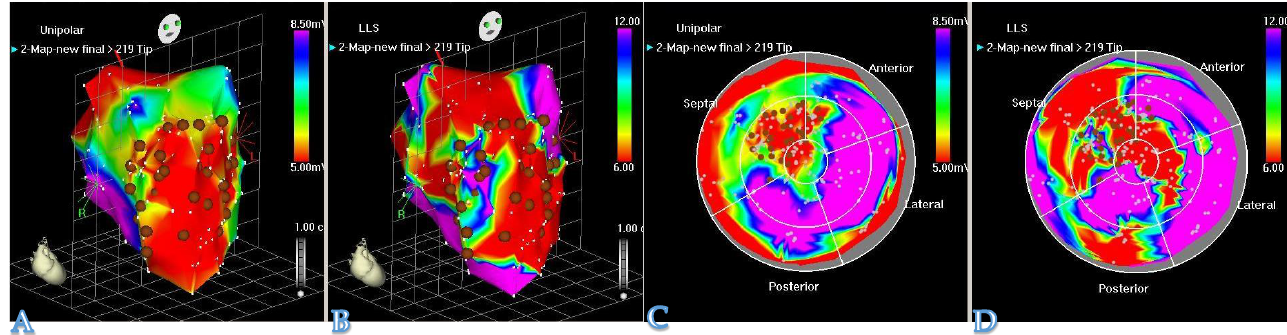
Figure 3. The NOGA ® system allows visualization of the LV contraction in 3D. NOGA is able to map the heart in a full 360 ◦ rotation. ( A , C ): unipolar voltage maps (mV) and ( B,D ): regional wall motion maps by local linear shortening (LLS%) can help the electromechanical assessment of the myocardium. NOGA shows viability on the left column; dense scarring is visible at the apex and the antero-septal wall (red); scar area (<0.5 mV) = RED; viable tissue (>1.5 mV) = PURPLE. Comparing the bipolar and unipolar maps, NOGA is able to define border zone areas better.